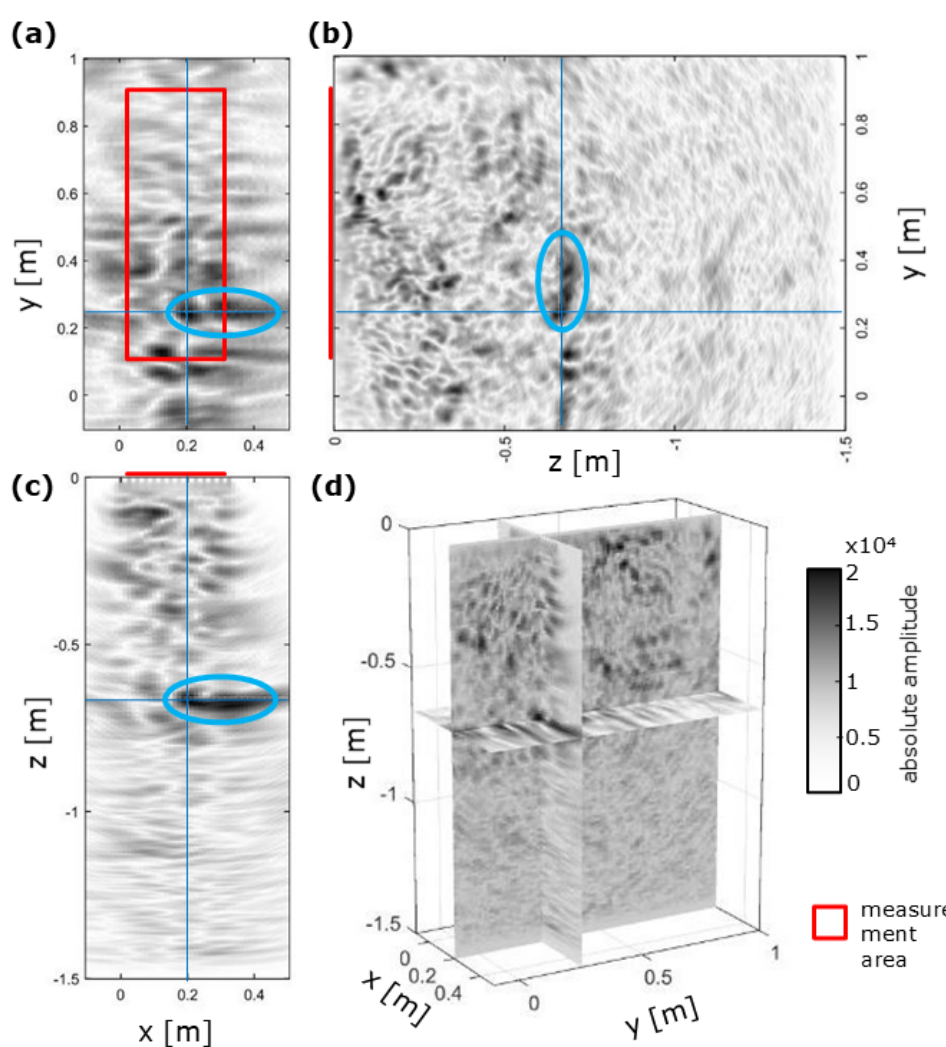
Figure 6. Ultrasonic imaging results of GSBV3 (after [22]) showing a distinct reflector (blue ellipse): ( a ) xy-slice (parallel to measurement surface), ( b ) corresponding yz-slice, ( c ) corresponding xz-slice, and ( d ) 3D overview of the presented